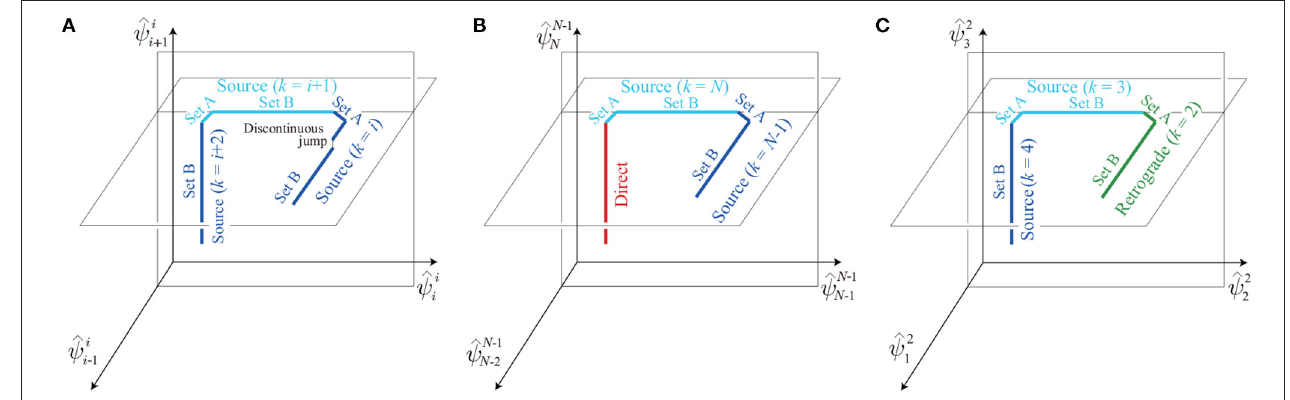
i , i 1, i 2) projected onto the ˆ ψ i i = + + 2) and source-wave gaits ( k =